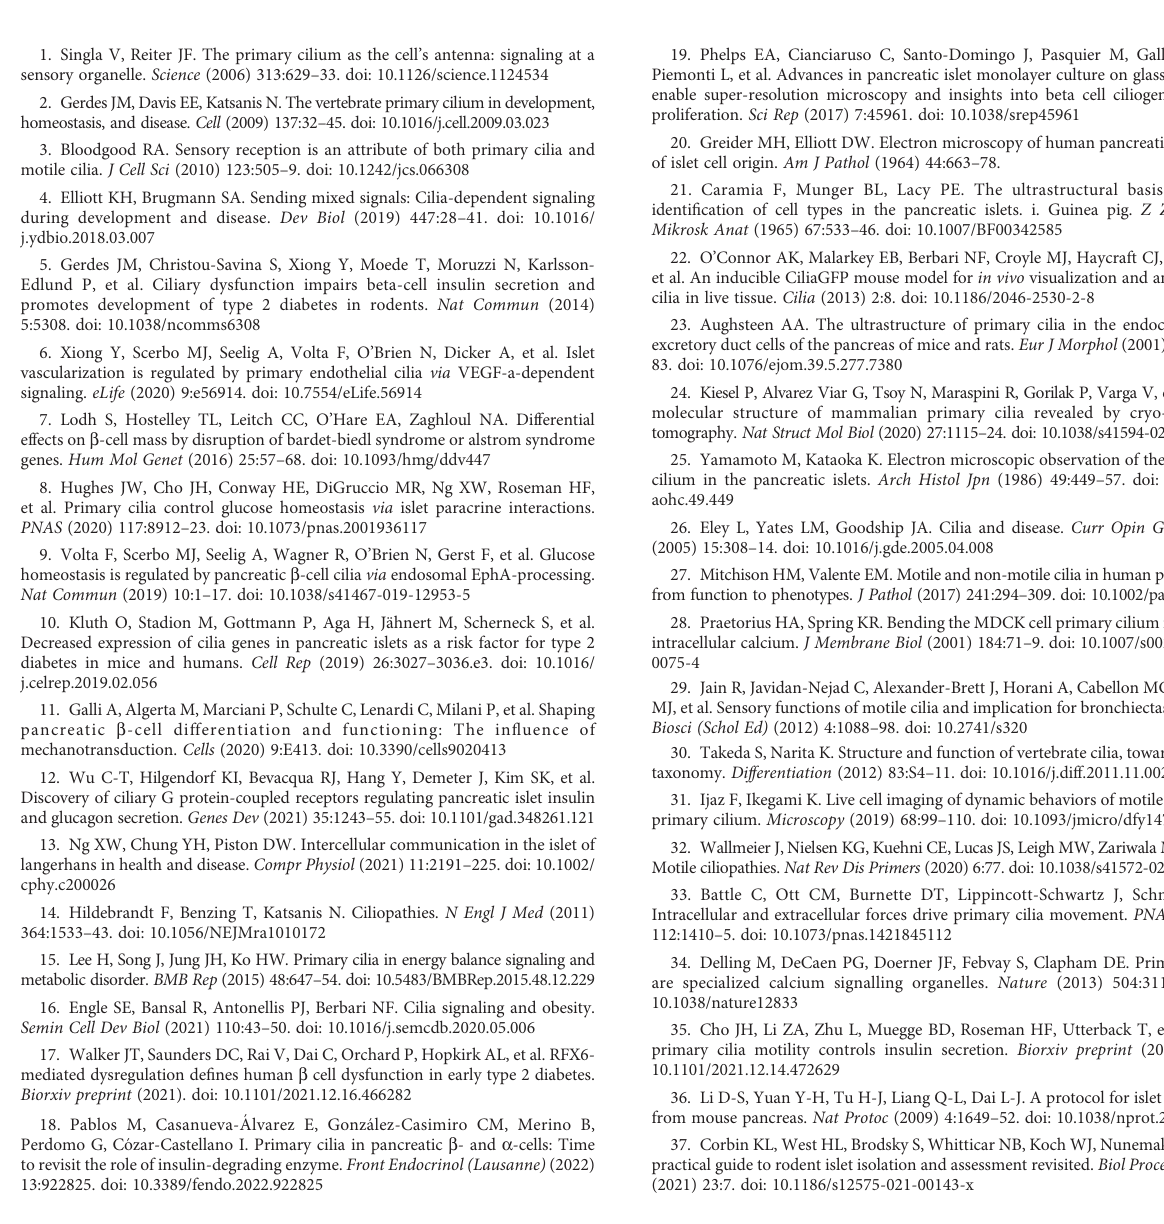
video. Scale bar, 10